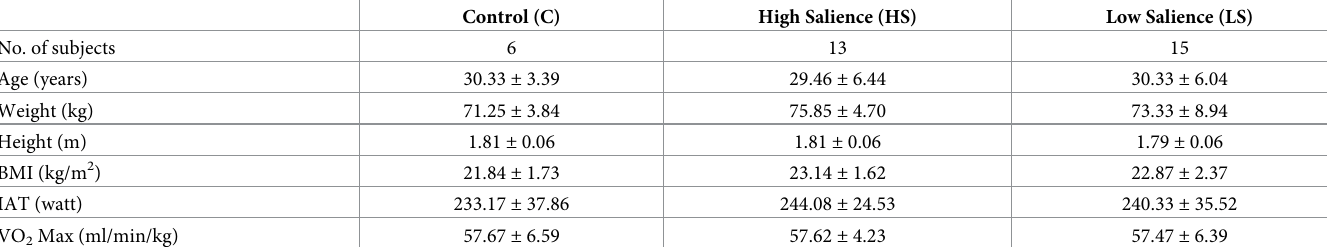
Table 1. Sample characteristics. Descriptive statistics are presented as mean value ± standard